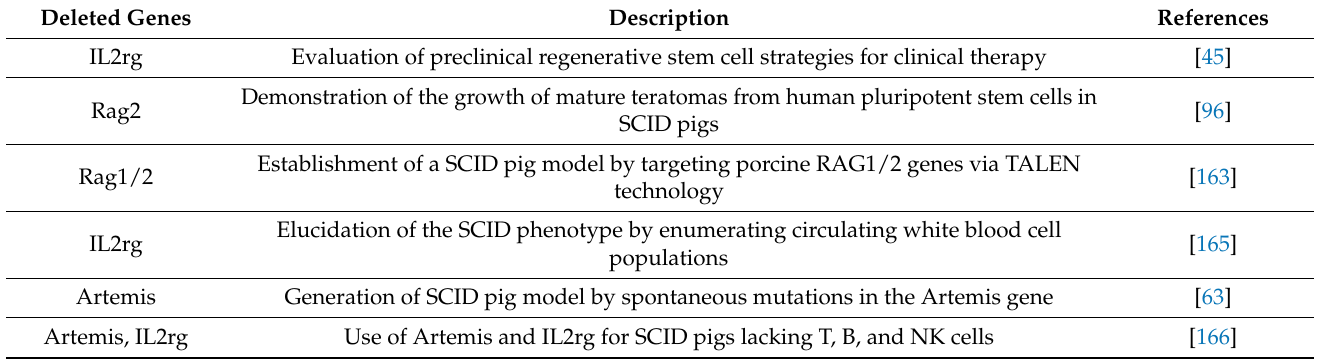
Table 4. Studies using SCID